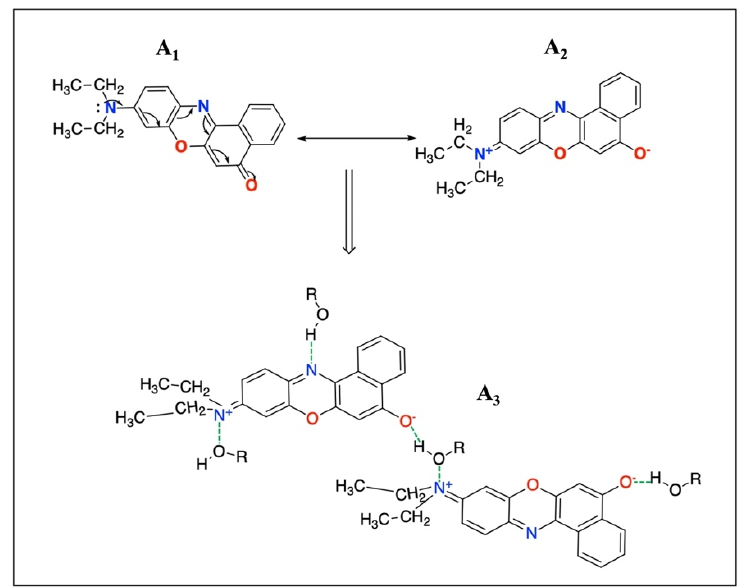
Figure 3. Chemical structures of NR. ( A 1 ) stable conformer without charge separation. ( A 2 ) conformer with charge separation stabilized by resonance between diamine nitrogen and oxygen. ( A 3 ) possible dimerization of NR molecules via H-bonding with alkanol.